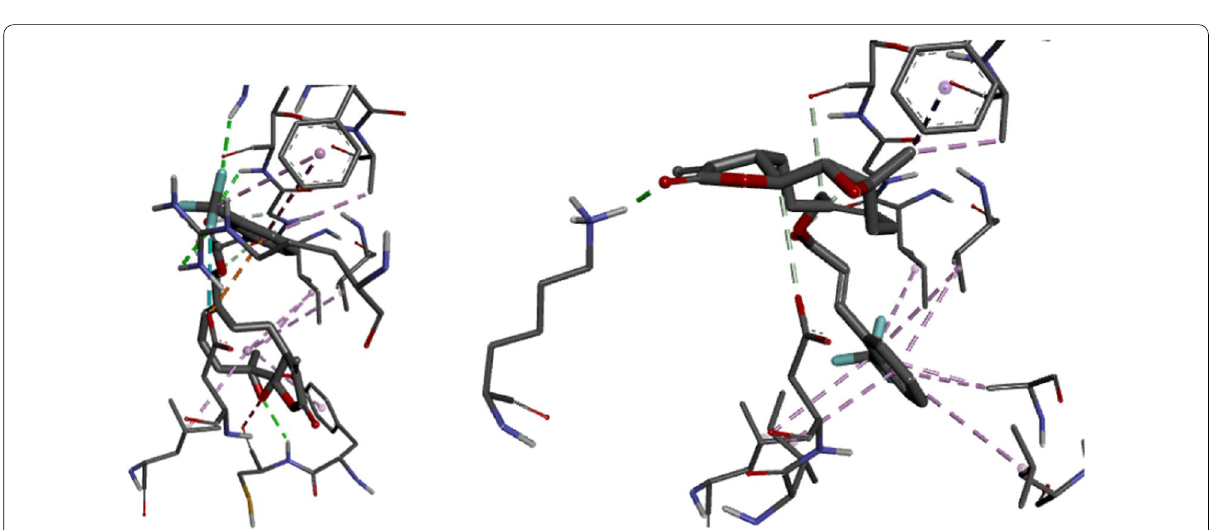
Fig. 9 3D representation of complex 9 and